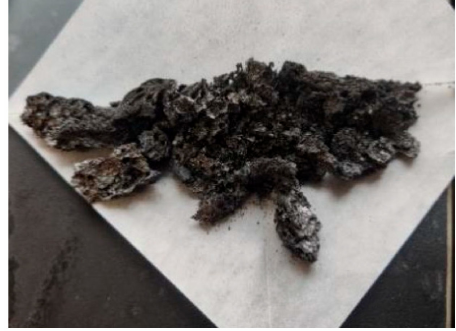
Figure 3. Pyrolysis